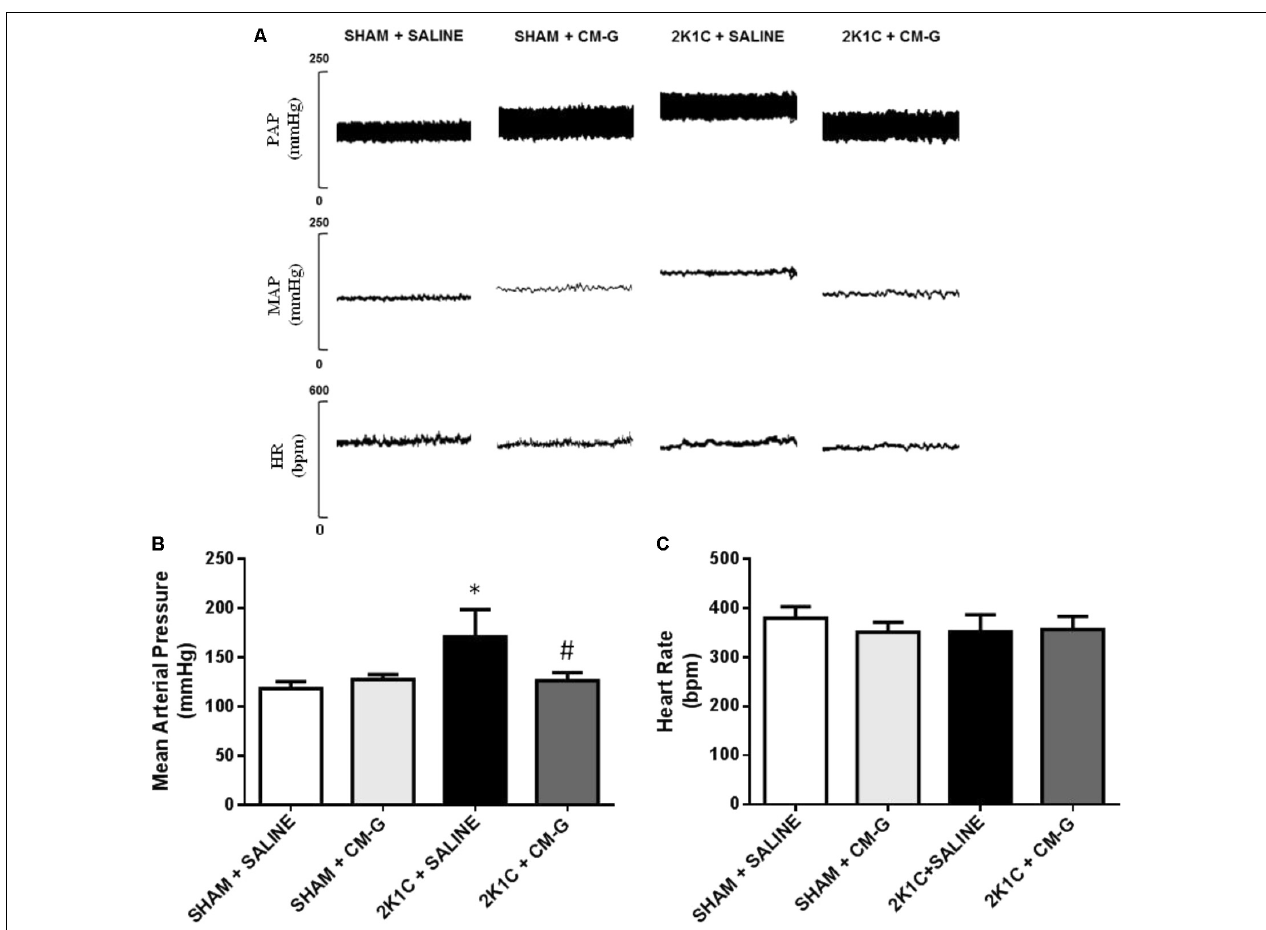
FIGURE 2 | Oral administration of carboxymethyl-glucan (CM-G) reduces blood pressure in renovascular hypertensive rats (A) Original tracings from one representative animal from each group (Sham + Saline, Sham + CM-G, 2K1C + Saline, 2K1C + CM-G) showing pulsatile arterial pressure (PAP), mean arterial pressure (MAP) and heart rate (HR). (B) Effects of oral treatment for 2 weeks on MAP in 2K1C and sham rats. (C) Effects of oral treatment for 2 weeks on HR in 2K1C and sham rats. ∗ P < 0.05 2K1C + SALINE vs SHAM + SALINE; # P < 0.05 2K1C + CM-G vs 2 K1C + SALINE.